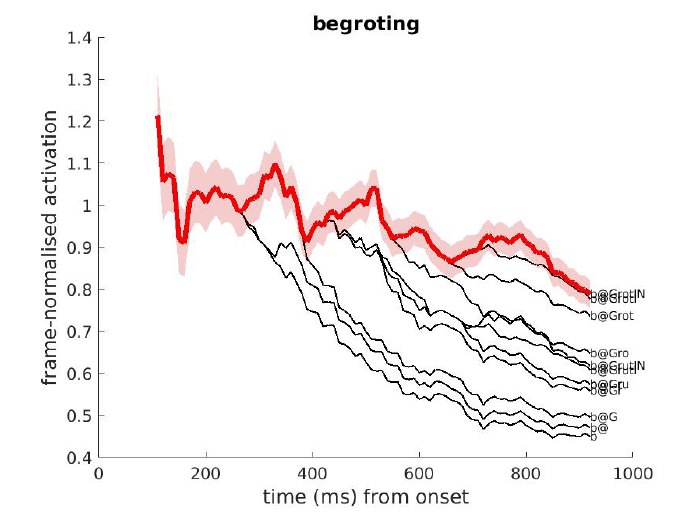
Figure 6. Activation plot of two competing words which form a minimal pair (clean recording condition): the Dutch real word ‘begroting’ (SAMPA / b@ GrotIN/, IPA / b@XrotIN /, Eng. ‘ budget ’) with ‘begroeting’ (SAMPA /b@ GrutIN/, IPA / b@XrutIN /, Eng. ‘ greeting ’). The audio is the real word ‘begroting’. The competitor word ‘begroeting’ looses directly after the /o/, at time 450 ms from onset. Clearly, many competitors overlap until the stimulus offset.